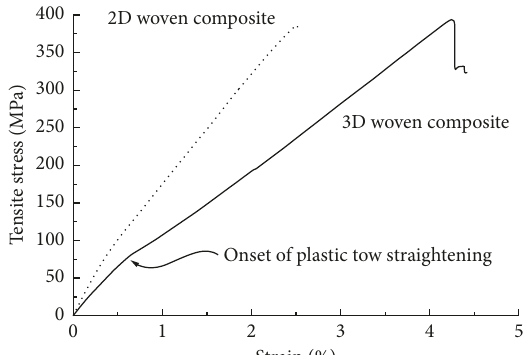
Figure 8: Comparison of tensile stress values versus elongation for composite materials made with 2D fabrics and 3D warp interlock fabrics [21].